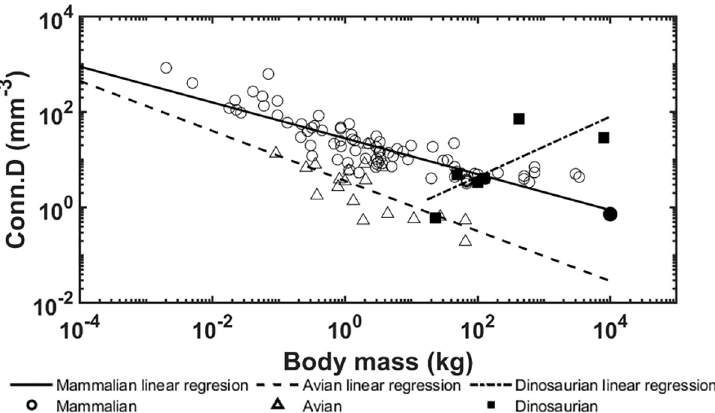
Fig 10. Logarithmically scaled plots of connectivity density (Conn.D) versus body mass. Pairwise comparisons indicate the dinosaur regression slope is different from the mammalian (p < 0.001) and avian (p < 0.001) slopes. The solid circle indicates the